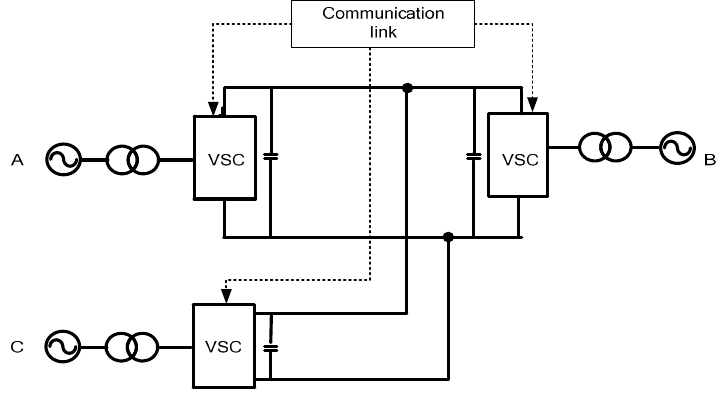
Figure 4. Control scheme of the VSC ‐ MTDC.